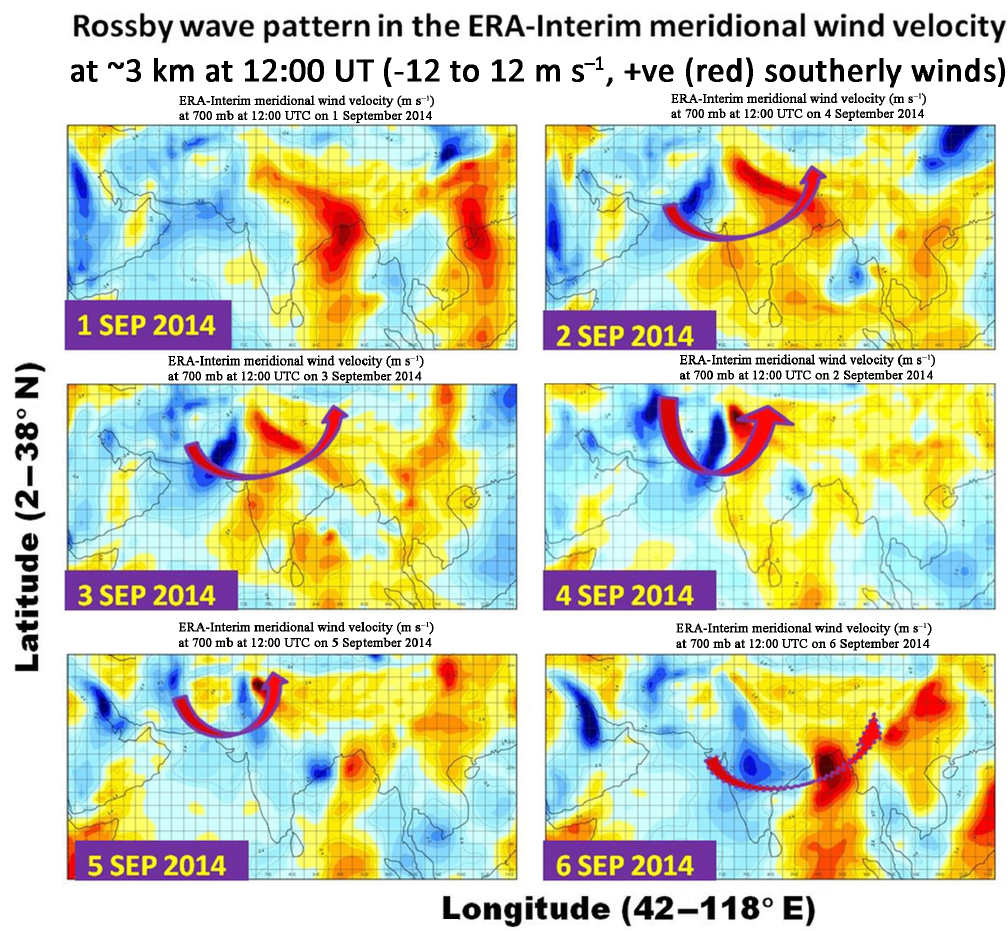
Figure 14. Synoptic-scale ERA-interim meridional wind velocity covering the Jammu and Kashmir region for 6 days from 1 to 6 Septem- ber 2014 (historical record flooding rainfall over this